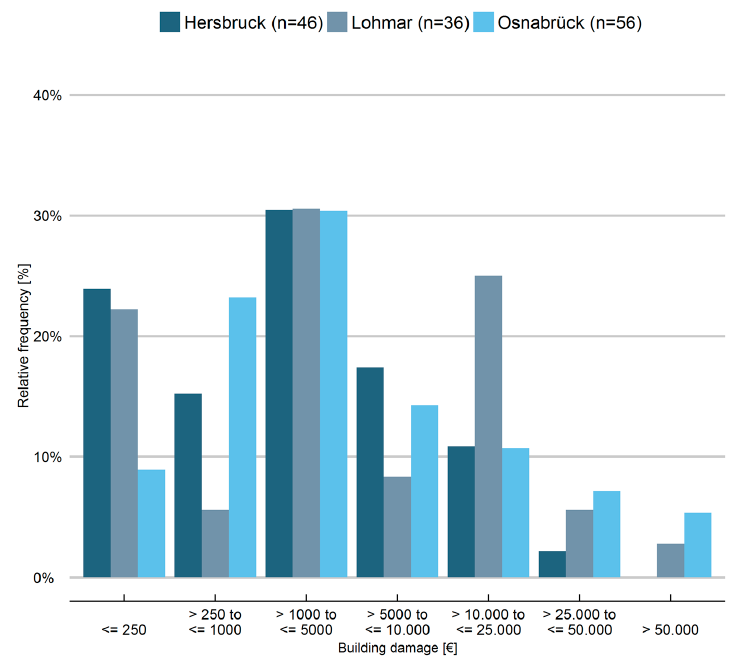
Figure 7. Distribution of classified building damage by study area based on inflation adjusted values.